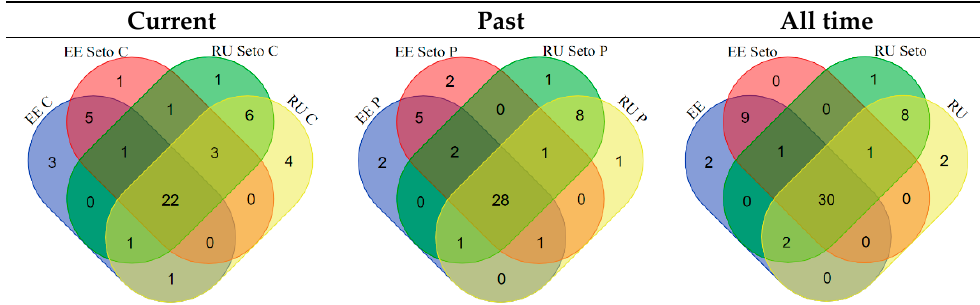
Figure 6. Overlapping of taxa used by Estonian (EE) and Russian (RU) Setos in the past (P) and currently (C). Only plants mentioned three or more times are analyzed.